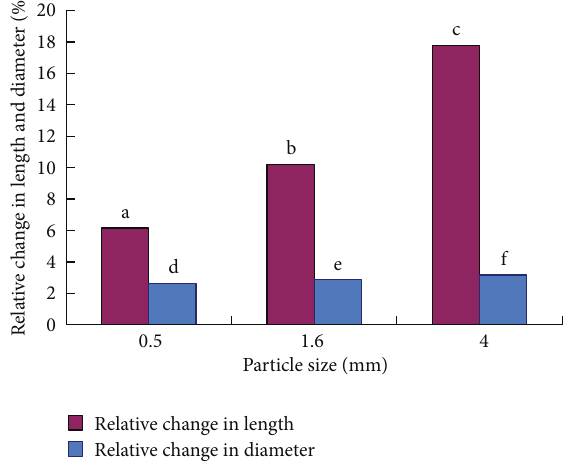
Figure 4: Relative change in length and diameter of briquette and particle size. Means of different letters are significantly different ( 𝑃 < 0.05